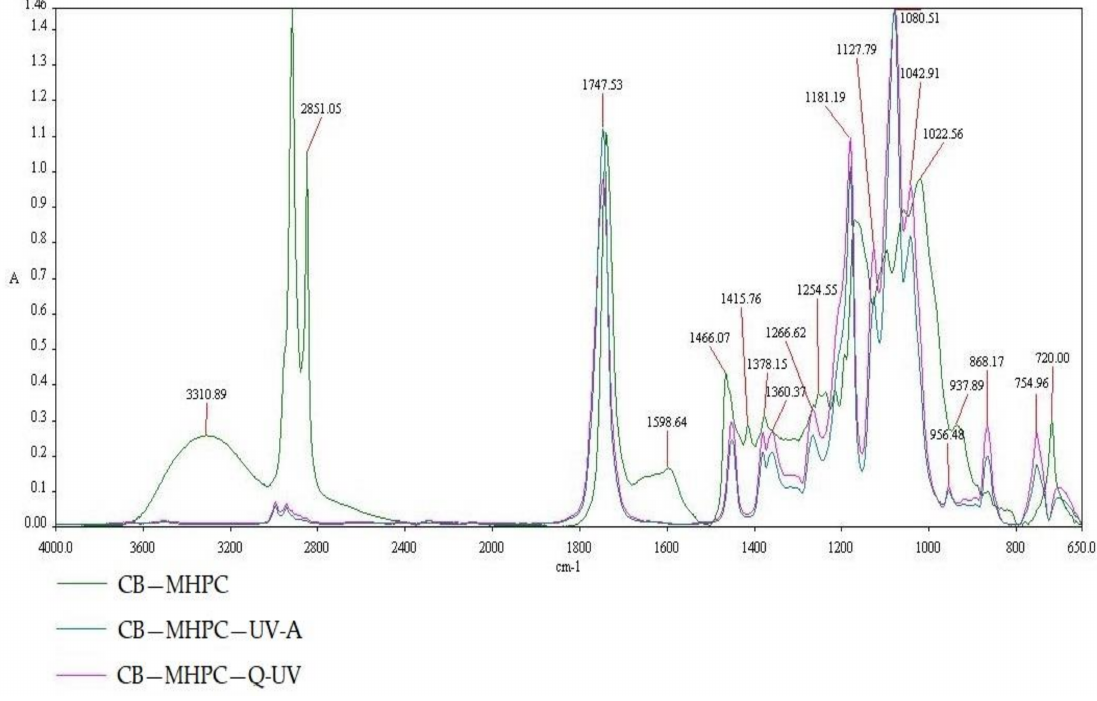
Figure 6. The FT-IR spectra of CB—MHPC, CB—MHPC—UV-A, CB—MHPC—Q-UV.